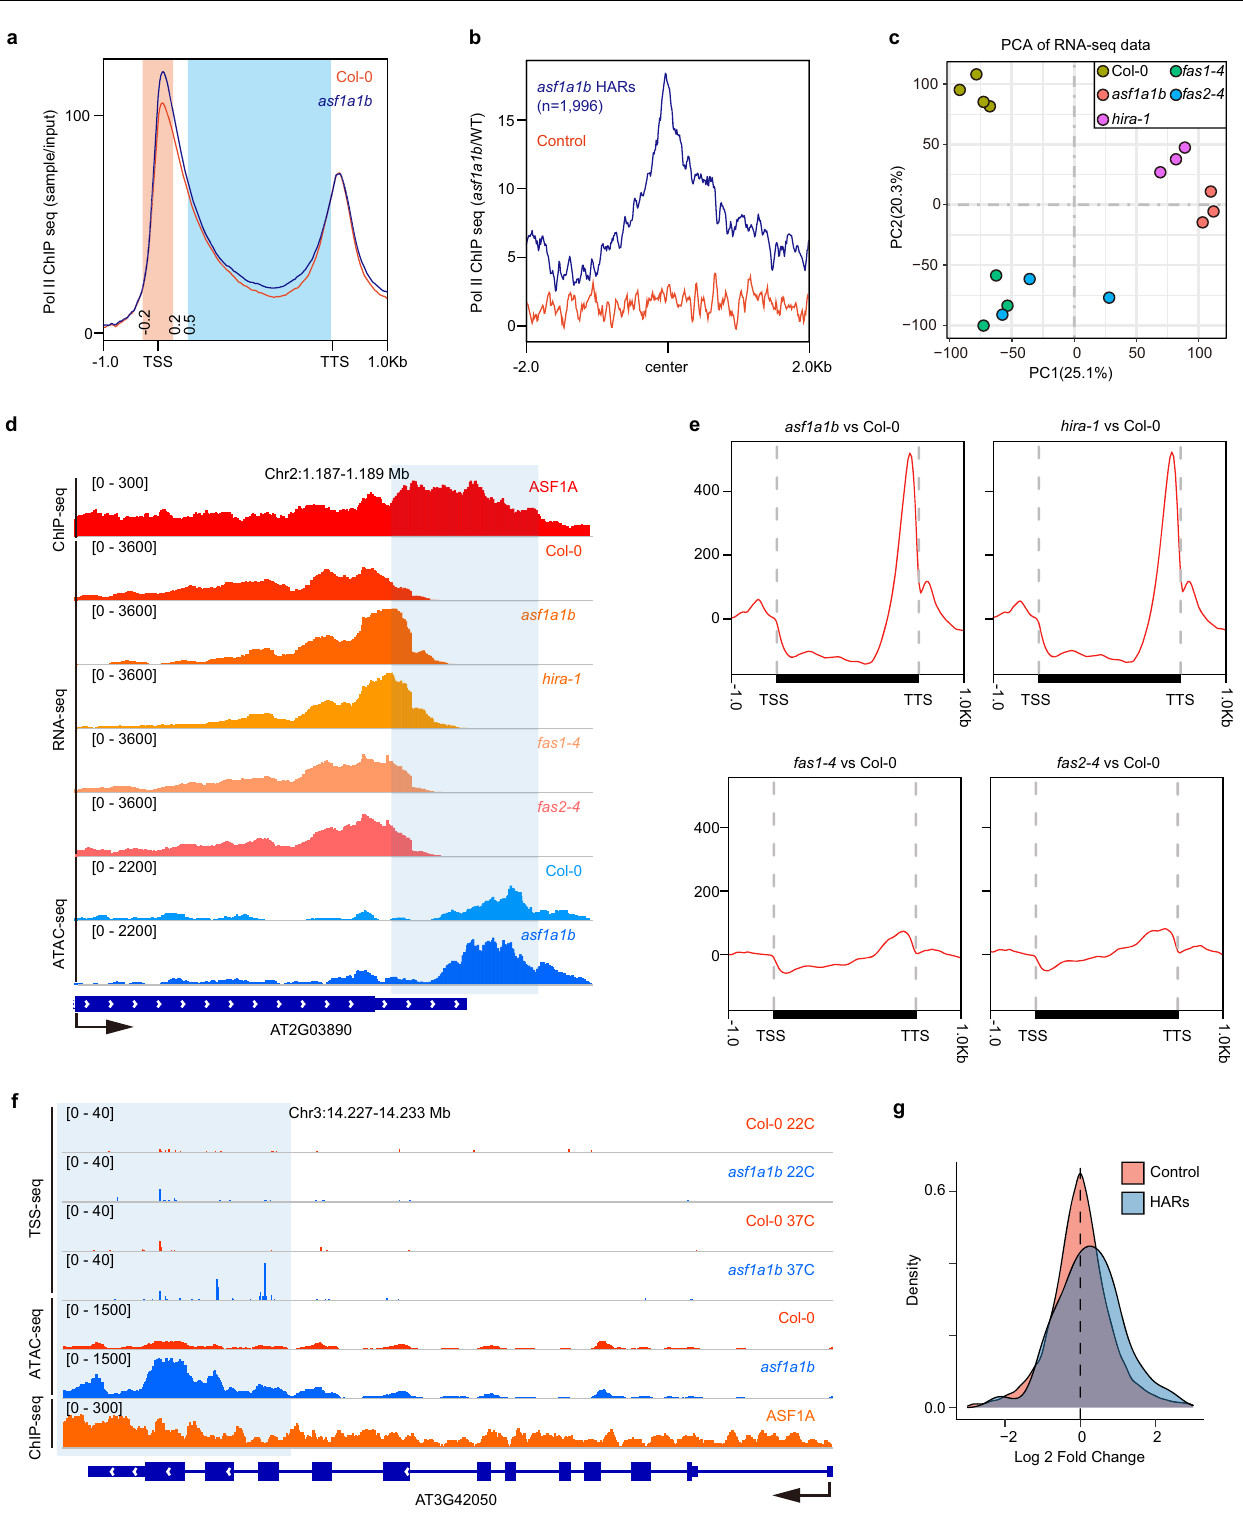
Fig. 5 | Transcriptomic analysis of H3 Histone chaperone mutants. a Metaplot showing S2S5-Phospho-Pol II ChIP-seq signal over gene body with 1 Kb fl anking sequences. b Metaplot of Pol II ChIP-seq signal over asf1a1b highly accessible regions (HAR, n =1996). c Principal component analysis (PCA) of RNA-seq data of Col-0, asf1a1b , hira-1 , fas1-4 , and fas2-4 . d Representative example ofRNA-seq with